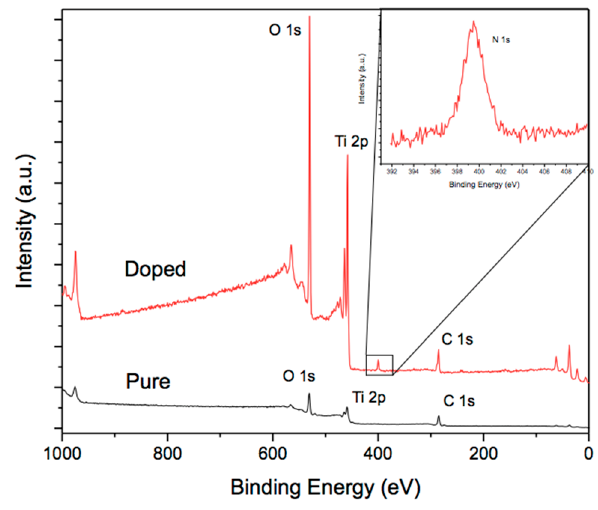
Figure 5. X-ray Photoelectron Spectroscopy (XPS) analysis for TiO 2 and N-TiO 2 catalysts.